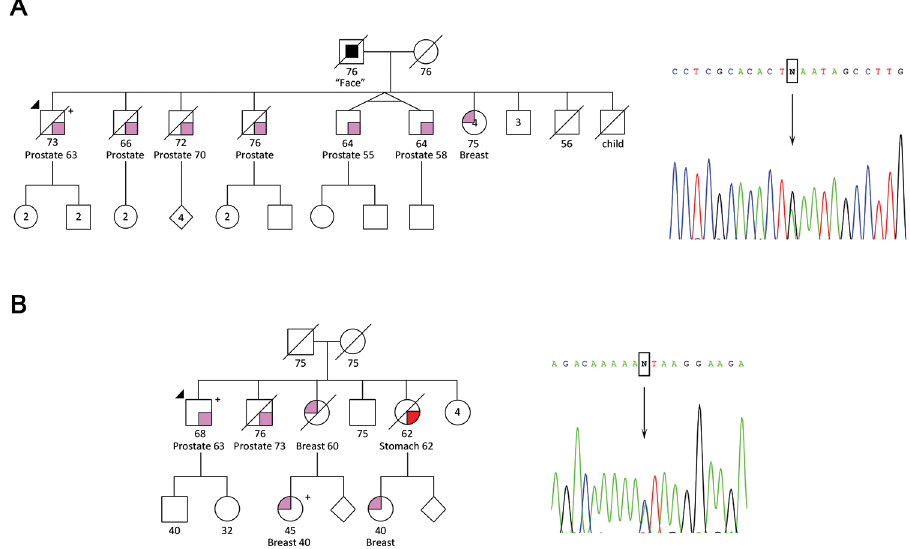
Fig 1. Pedigrees of patients carrying truncating/deleterious mutations in the known PrCa risk genes ATM and CHEK2 . (A) Patient HPC177 harboring the ATM stop mutation c.652C > T. (B) Patient HPC395 harboring the CHEK2 splicing mutation c.593-1G > T. Electropherograms of the Sanger sequencing validations are